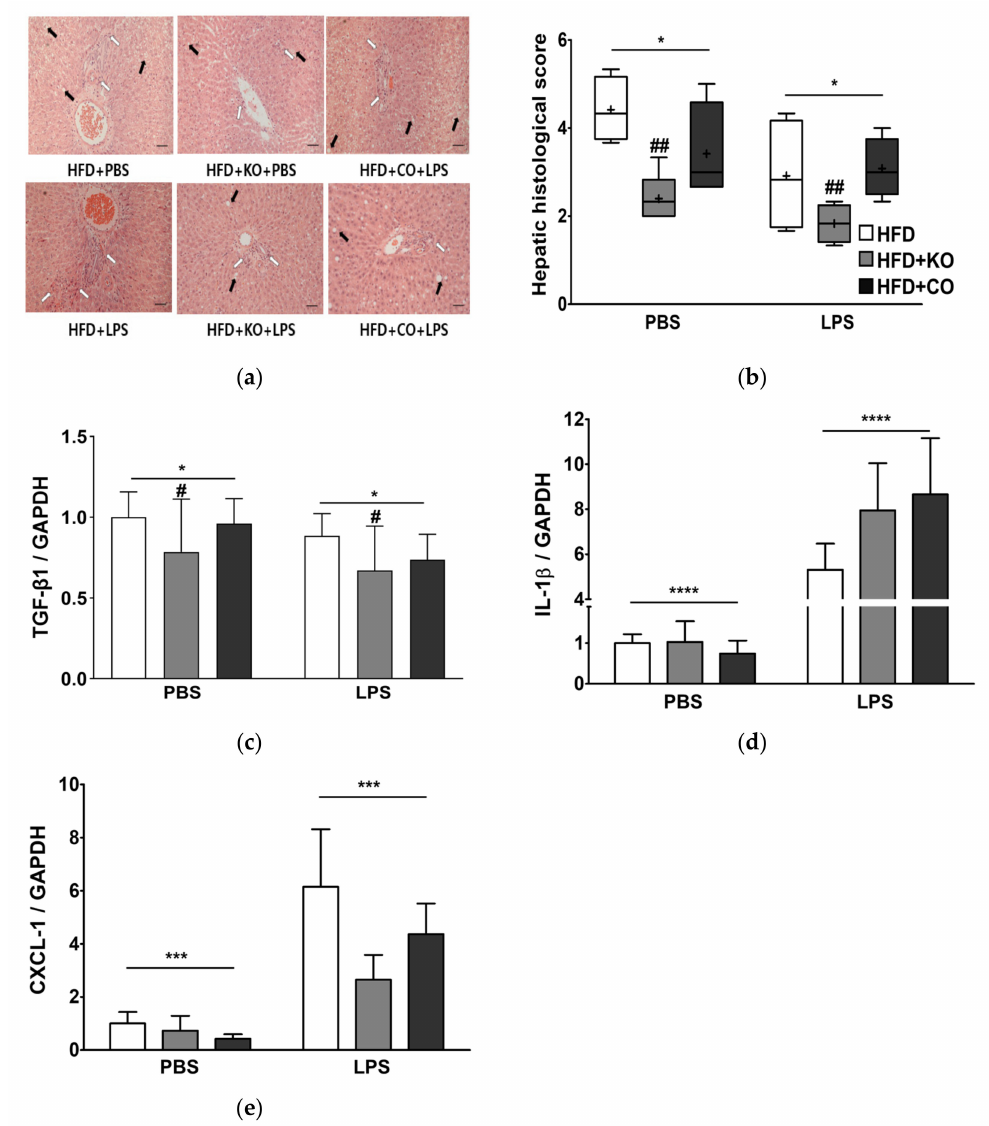
Figure 6. Effects of partial replacement of dietary fat with krill oil or coconut oil on the hepatic histopathology, and mRNA expression of proinflammatory genes in rats after the LPS challenge. Sprague Dawley rats were fed either a high-fat diet (HFD), HFD partially replaced with krill oil (HFD + KO), or coconut oil (HFD + CO) for 10 weeks, and then treated with PBS or LPS (1 mg/kg) for 24 h. ( a ) Hematoxylin and eosin (H&E) staining of liver tissue (bar = 50 µ m, 20 × magnification); black arrow indicates lipid accumulation and white arrow indicates inflammatory foci. ( b ) hepatic histological score, ( c ) transforming growth factor- β 1 (TGF- β 1), ( d ) interleukin 1 beta (IL-1 β ) level, and ( e ) chemokine (C-X-C motif) ligand 1 (CXCL-1) mRNA expression levels were assessed. Values are displayed as box-and-whisker plots, n = 8 per individual group. Data were analyzed by two-way ANOVA followed by Tukey’s multiple comparisons test to determine the interactions or the main effects (diet and LPS stimulation). Asterisk indicates a significant main effect for LPS (* p < 0.05, *** p < 0.001, **** p < 0.0001). Pound indicates a significant main effect for diet ( # p < 0.05, ## p < 0.01). The mean values are indicated by “+” signs. HFD, high-fat diet; HFD + KO, high-fat diet + krill oil; HFD + CO, high-fat diet + coconut oil; PBS, phosphate-buffered saline; LPS,